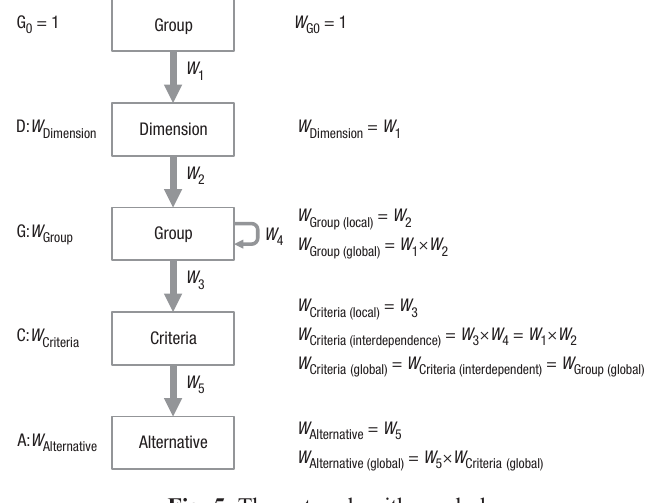
Fig. 5. The network with